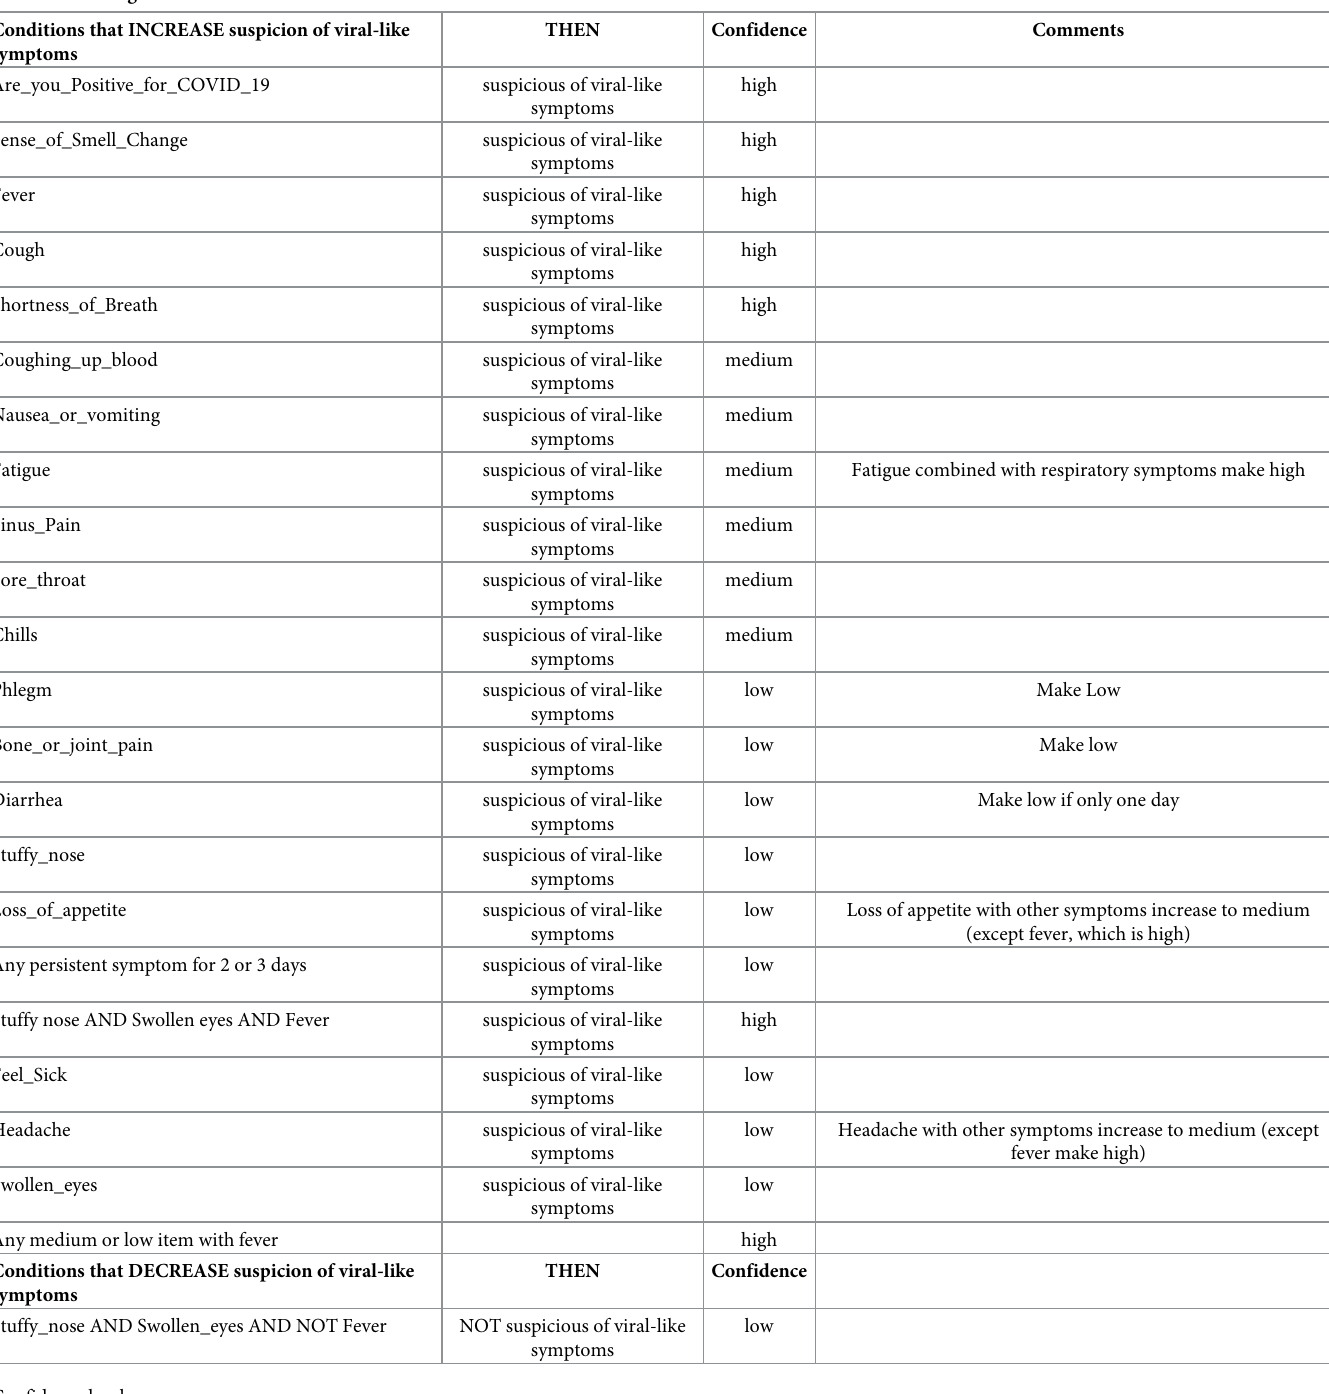
Table 1. Labeling model